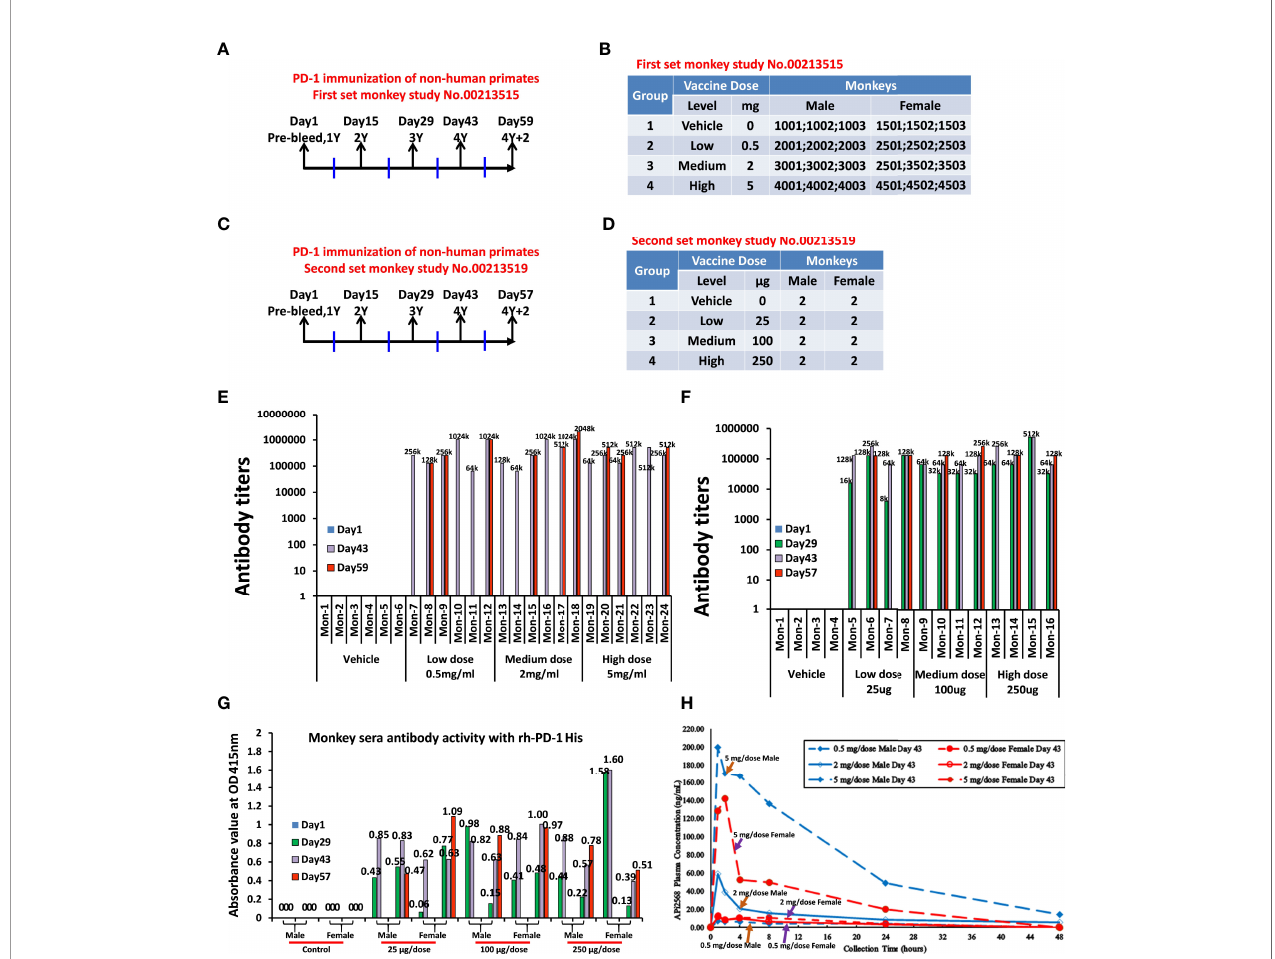
FIGURE 4 | Non-human primates ’ study, anti-APi2568 antibody in monkey serum activity with rh-PD-1 His and Half-life of APi2568 (MVF-PD-1(92)) in the monkey plasma. (A) First set of monkey study No.00213515, non-human primates, cynomolgus monkeys, were used in this study. The monkeys were immunized three times, which point 1Y, 2Y, 3Y and 4Y with 2-weeks interval. The bleeds were collected at pre, 2Y+2/3Y, 3Y+2 and 4Y and 4Y+2. (B) There are four groups and 6 monkeys in No.00213515 of each group. Group 1 is the control group, which was treated with only ISA 720 and water. Group 2, group 3, and group 4 are peptide treatment groups, which were treated with low 0.5 mg/dose, medium 2 mg/dose, and high 5 mg/dose in No.00213515; (C) on the second set of non-human primate study No.00213519, 16 of cynomolgus monkeys were used in this study. The monkeys were immunized three times, which point 1Y, 2Y, 3Y, and 4Y with 2- week intervals. The bleed was collected at pre, 2Y+2/3Y, 3Y+2 and 4Y and 4Y+2. (D) There are four groups and 4 monkeys in No.00213519 of each group. Group 1 is the control group, which was treated with only ISA 720 and water. Group 2, group 3, and group 4 are peptide treatment groups, which were treated with low 25 m g/dose, medium 100 m g/dose, and high 250 m g/dose of peptide vaccine in No.00213519; (E, F) Immunogenicity of peptide-based vaccines in non-human primates. ELISAs were used to detect antibody titers in sera of both monkey study No.00213515 and No.00213519, respectively; the numbers indicated the highest dilution of sera, titers; (G) Absorbance value at OD 415 nm of monkey serum immunized with APi2568 [MVF-PD-1(92)] peptide vaccine against human recombinant protein PD-1 activity. The 1:100 diluted sera were used. (H) Half-life of APi2568 (MVF-PD-1(92) peptide vaccine in the monkey plasma at day 43 after immunization, which indicated that the relatively higher dose has relatively longer half-life in the monkey plasma, both in male and